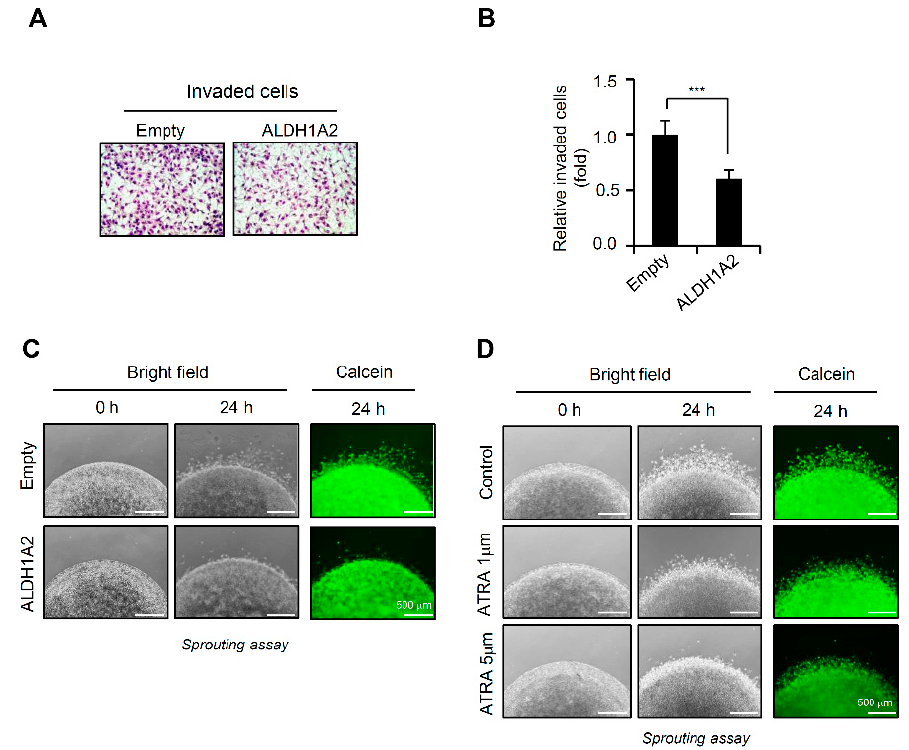
Figure 5. Effects of forced expression of ALDH1A2 on invasive potential of ovarian cancer cells. ( A , B ) Invasion assay; RMG ‐ I cells transfected with either the empty vector or ALDH1A2 expression vector for 24 h were loaded into the upper chamber and then fetal bovine serum (FBS, 5%) was added to the lower chamber. After 24 h, the cells that invaded the lower chamber were stained with DiffQuik ( A ) and quantified ( B ) under a microscope. Data are expressed as means ± SD. Statistical significance was assessed using an unpaired t ‐ test. *** p < 0.005. ( C ) Sprouting assay; RMG1 cells ectopically expressing ALDH1A2 were embedded with Matrigel and incubated for 24 h. Phase contrast images were observed (left panel). Calcein ‐ AM ‐ stained cells were visualized using a fluorescence microscope (right panel). Original magnification: 4×. Scale bar, 500 μ m. ( D ) Sprouting assay using RMG1 cells incubated in the presence or absence of ATRA (1 μ M, 5 μ M). Phase contrast images were observed (left panel). Calcein ‐ AM ‐ stained cells were visualized using a fluorescence microscope (right panel). Original magnification: 4×. Scale bar, 500 μ m.